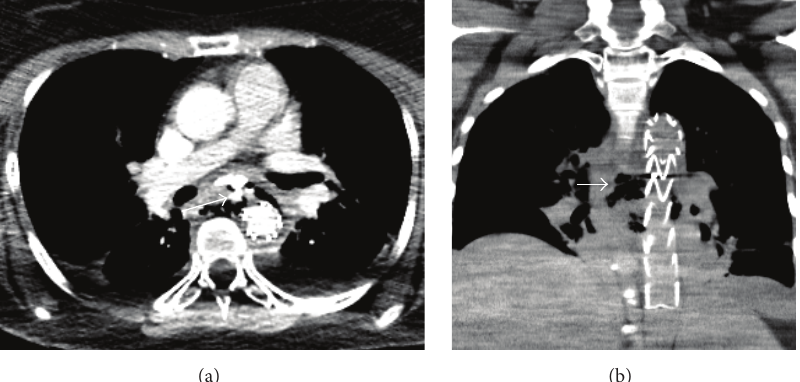
Figure 2: CT scan using oral hydrosoluble contrast material: (a) axial and (b) coronal reconstruction. (a) There is leakage of the contrast material from the esophagus to the posterior mediastinum (white arrow); the aortic stent was placed demonstrating that the esophageal wall is perforated. (b) Mediastinal collection with air bubbles within it (white arrow), surrounding the aorta with the stent placed in an adequate